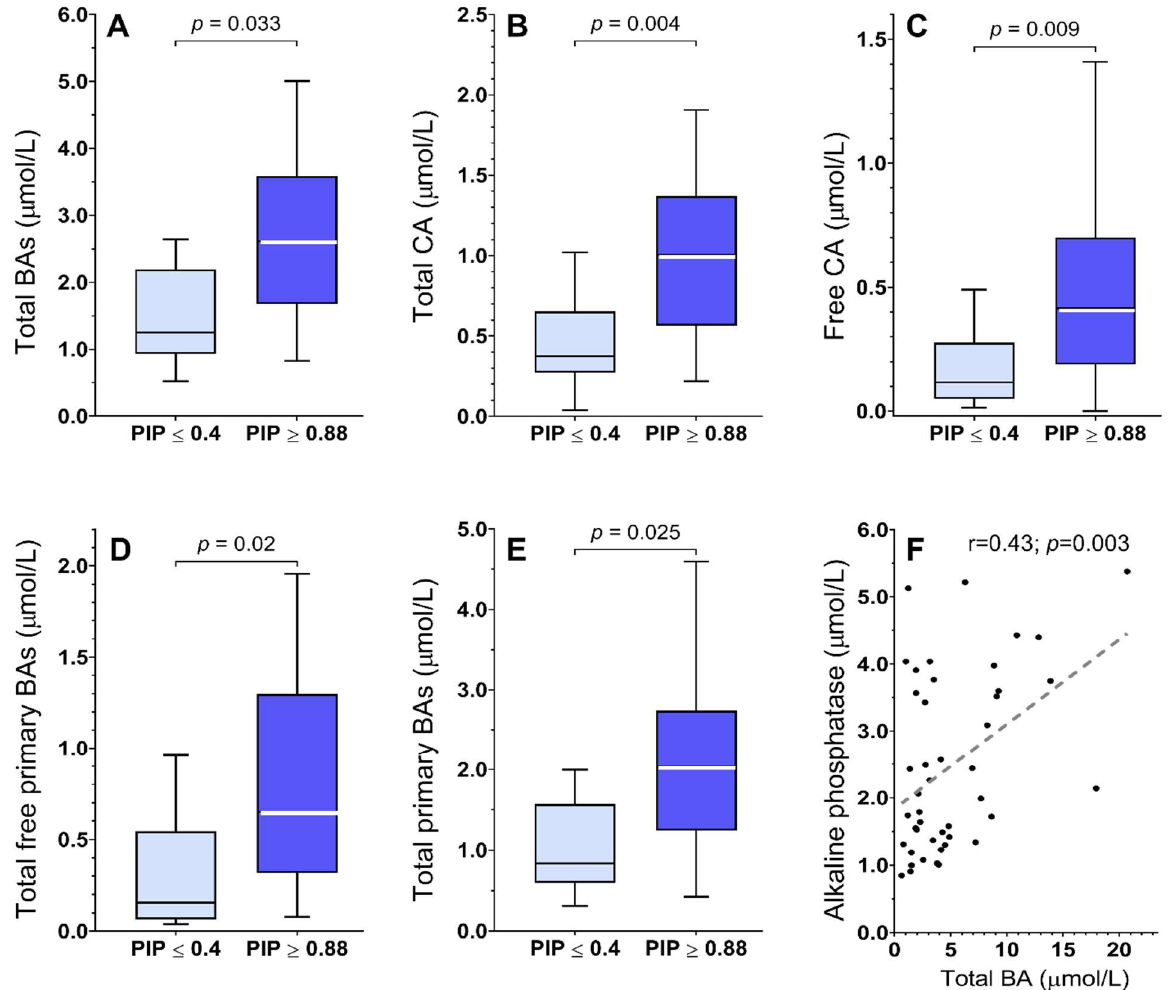
Figure 2. Primary bile acid (BA) concentrations in pwCF classified according to their pancreatic insufficiency prevalence (PIP) score. ( A ): Concentration of total BAs. ( B ): Total cholic acid (CA) concentrations. ( C ): Free cholic acid (CA) concentrations. ( D ): Total concentrations of free primary BAs, i.e., CA+CDCA. ( E ): Total concentrations of all primary BAs, i.e., CA+G-CA+T-CA+ CDCA+G- CDCA+T-CDCA. ( F ): Significant correlation between the total concentration of bile acids and alkaline